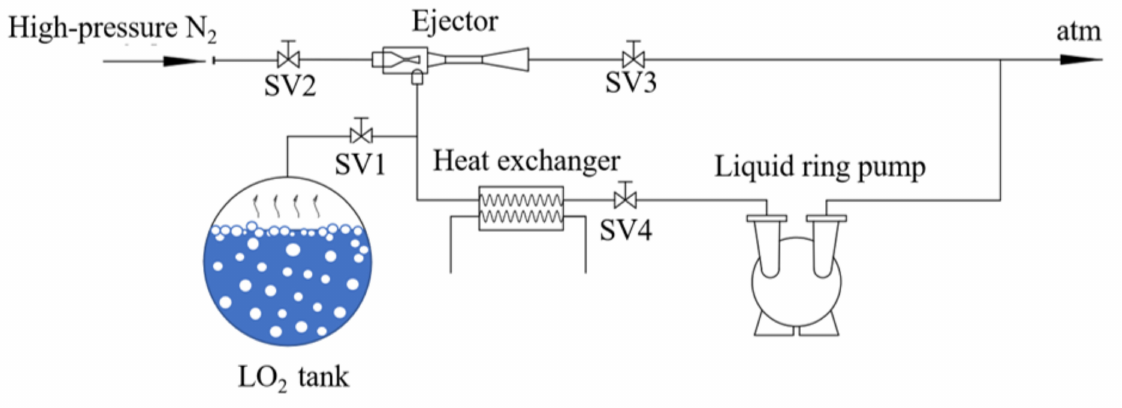
Figure 1. Ejector/liquid ring pump vacuum subcooling